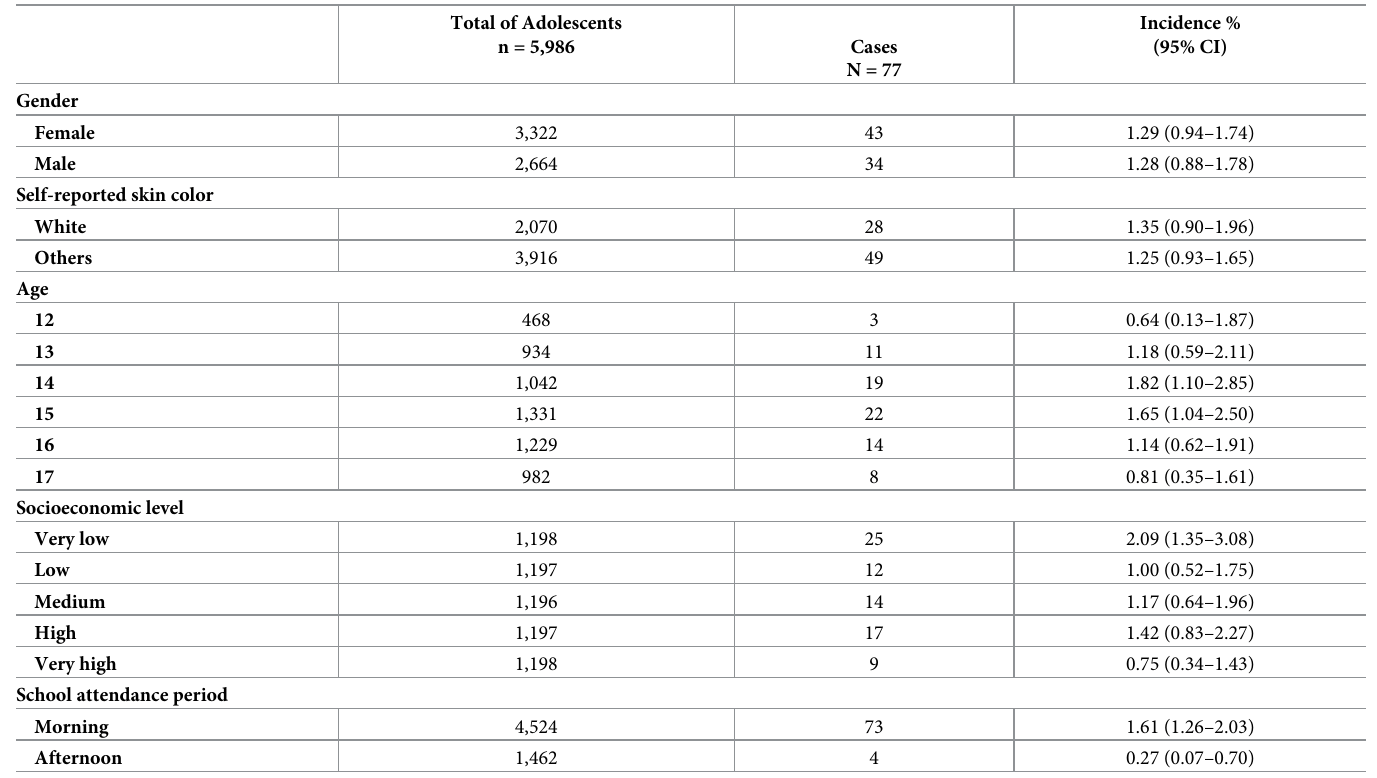
Table 1. Incidence and descriptive characteristics of the adolescents of the ERICA